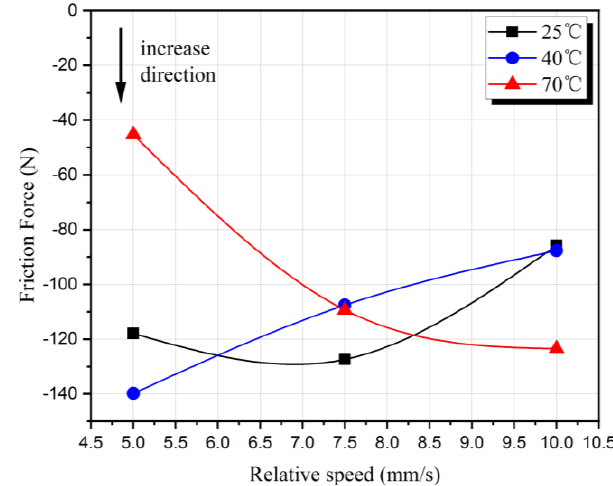
Figure 5. The relationship between the relative speed and friction force in different temperatures.